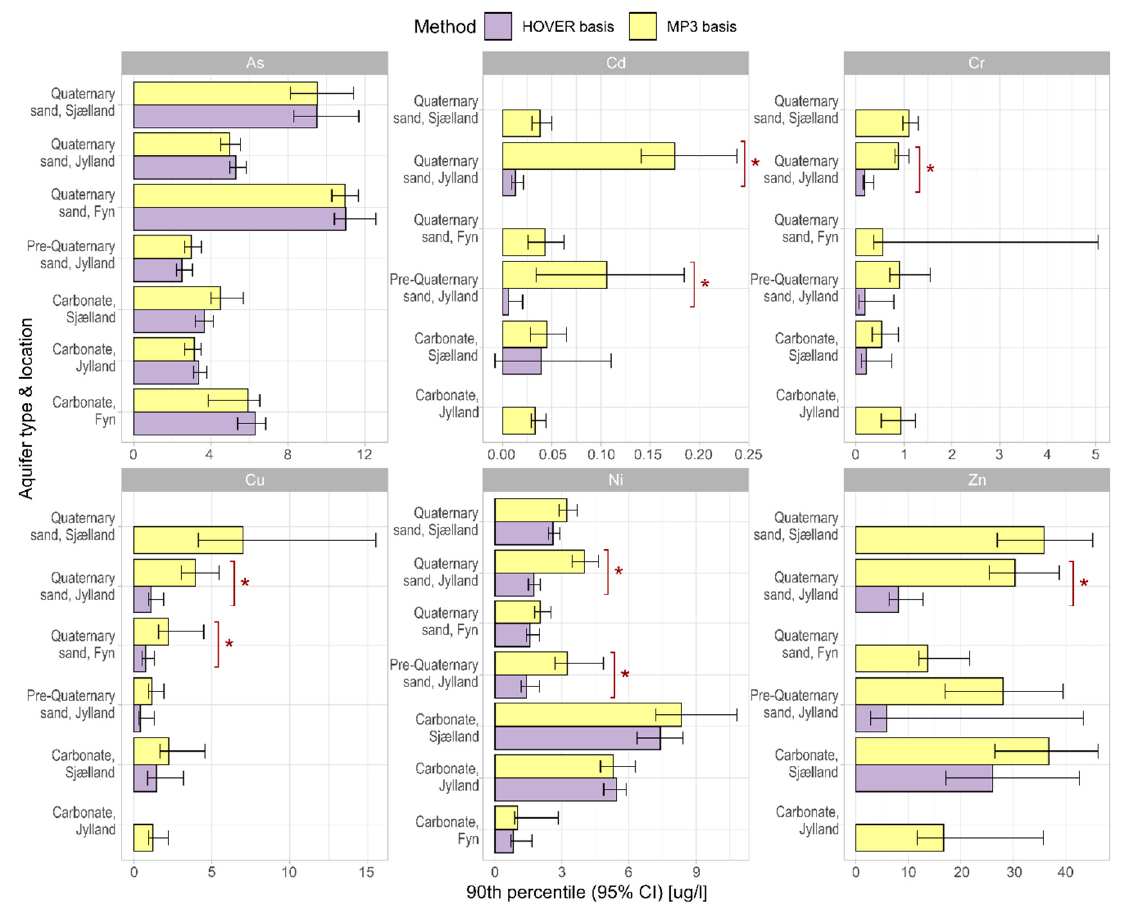
Figure 9. NBLs (x-axis, µg/L) for As, Cd, Cr, Cu, Ni, and Zn (see gray panel labels), calculated based on HOVER basis and MP3 basis methods considering the aquifer type and location (y-axis). The symbol * indicates a statistically significant difference based on the 95% confidence intervals (CI). See also Table S5 for the numbers and Figure 1 for geographical reference.